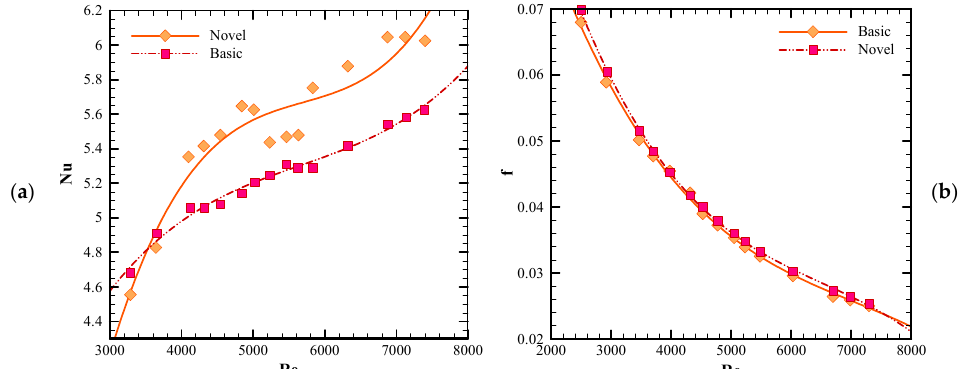
Figure 6. Variation of average ( a ) Nusselt number and ( b ) friction factor for a basic system without a turbulator and novel PTSC equipped with a turbulator and filled with nanofluid at ϕ = 0.019% and time 12:30 versus different Reynolds numbers.